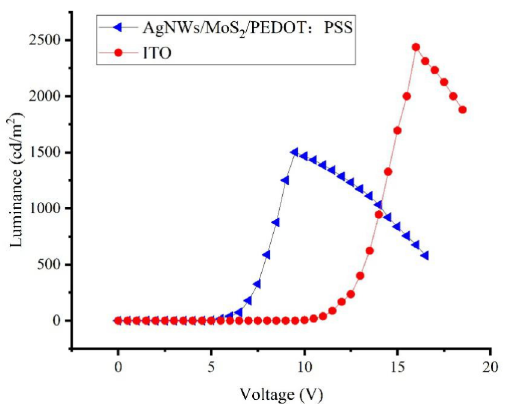
Figure 11. Voltage brightness curve of OLED